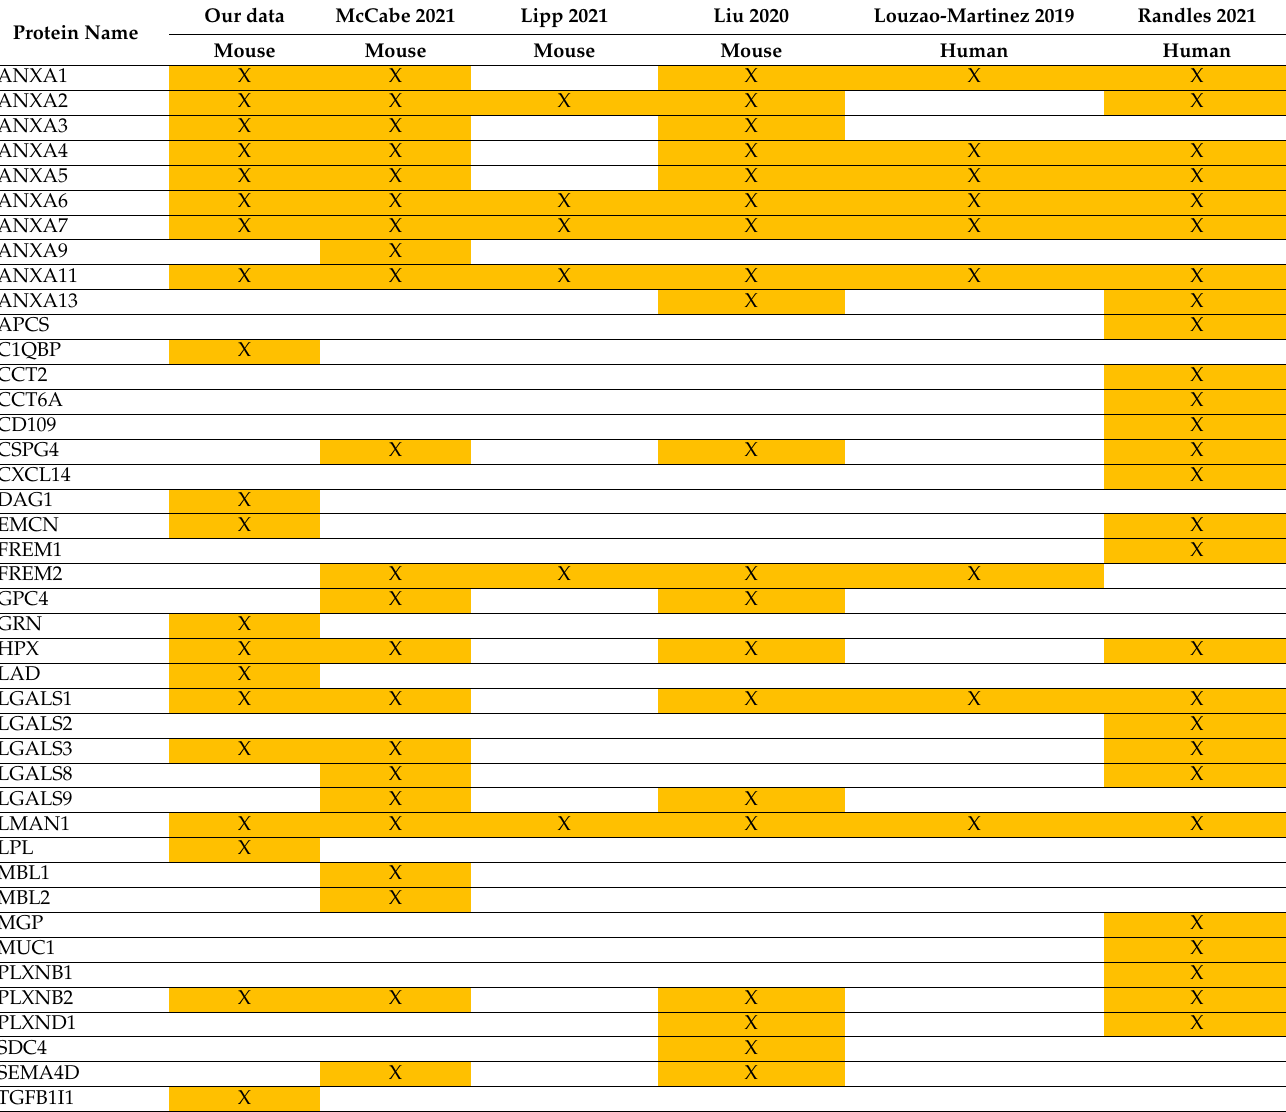
Table A14. The combined list of matrisome-associated proteins belonging to the category of ECM- affiliated proteins and identified in mouse and human kidneys. The mouse matrisome proteins were obtained from our data and extracted from references [20,28,30]. Human matrisome pro- teins were obtained from the studies [31,32]. Highlighted “X” refers to identified protein in the corresponding